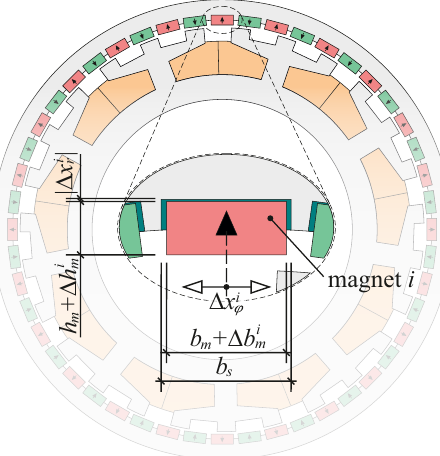
Figure 1. Outer rotor Vernier machine considered for the case study. Major parameters are given in Table